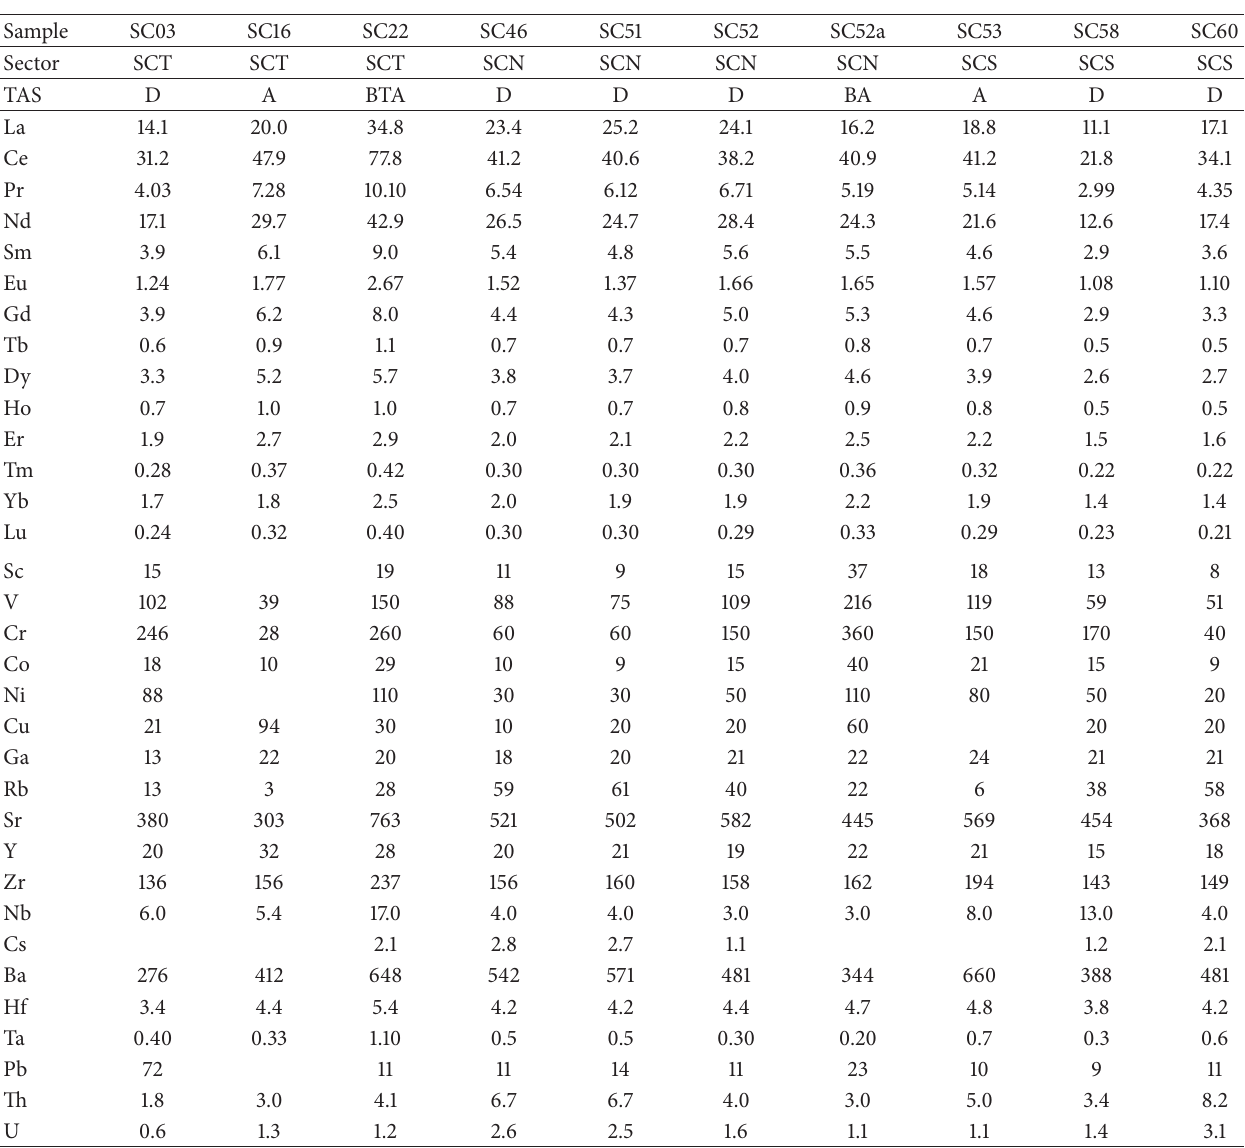
Table 3: Trace element composition (ppm) for the volcanic rocks from the Sierra de las Cruces